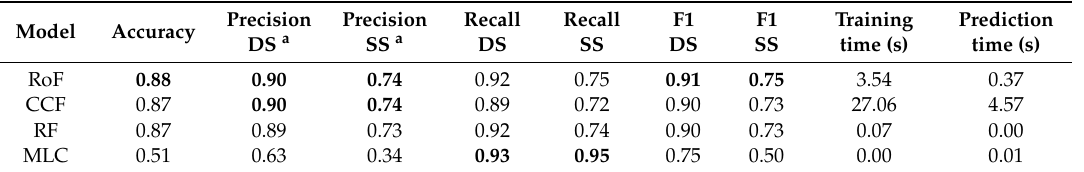
Table 5. Accuracy, precision, recall, and F1 of the model performing for the selected Sentinel-2 scene; best performance is indicated by the characters in